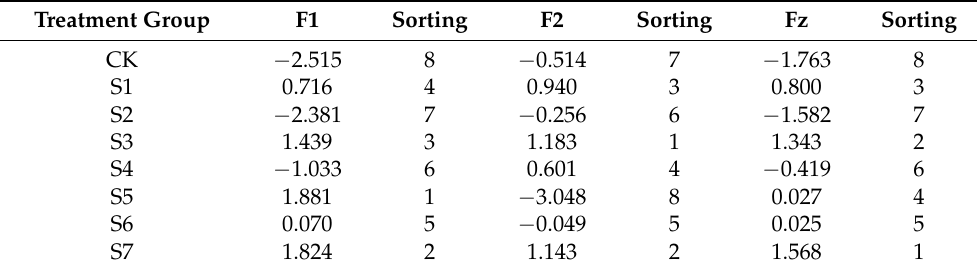
Table 2. Steroidal saponin principal component score of P. polyphylla var. Yunnanensis .